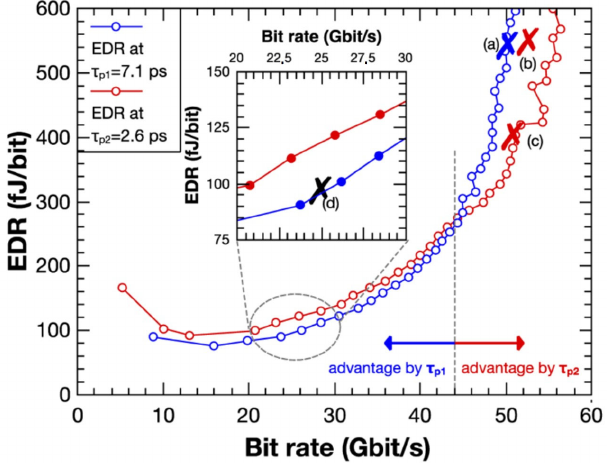
Figure 6. EDR and BR values from small signal measurements, for a long photon lifetime (blue) and a short photon lifetime (red). A spectral efficiency of M = 2.1 bits was observed experimentally by the large signal measurements, marked with (a) and (c) for both photon lifetimes. The data points marked with (a), (b), and (c), as well as the curves, are achieved with the identical device. Datapoint (d) was measured with a different but similar aperture device